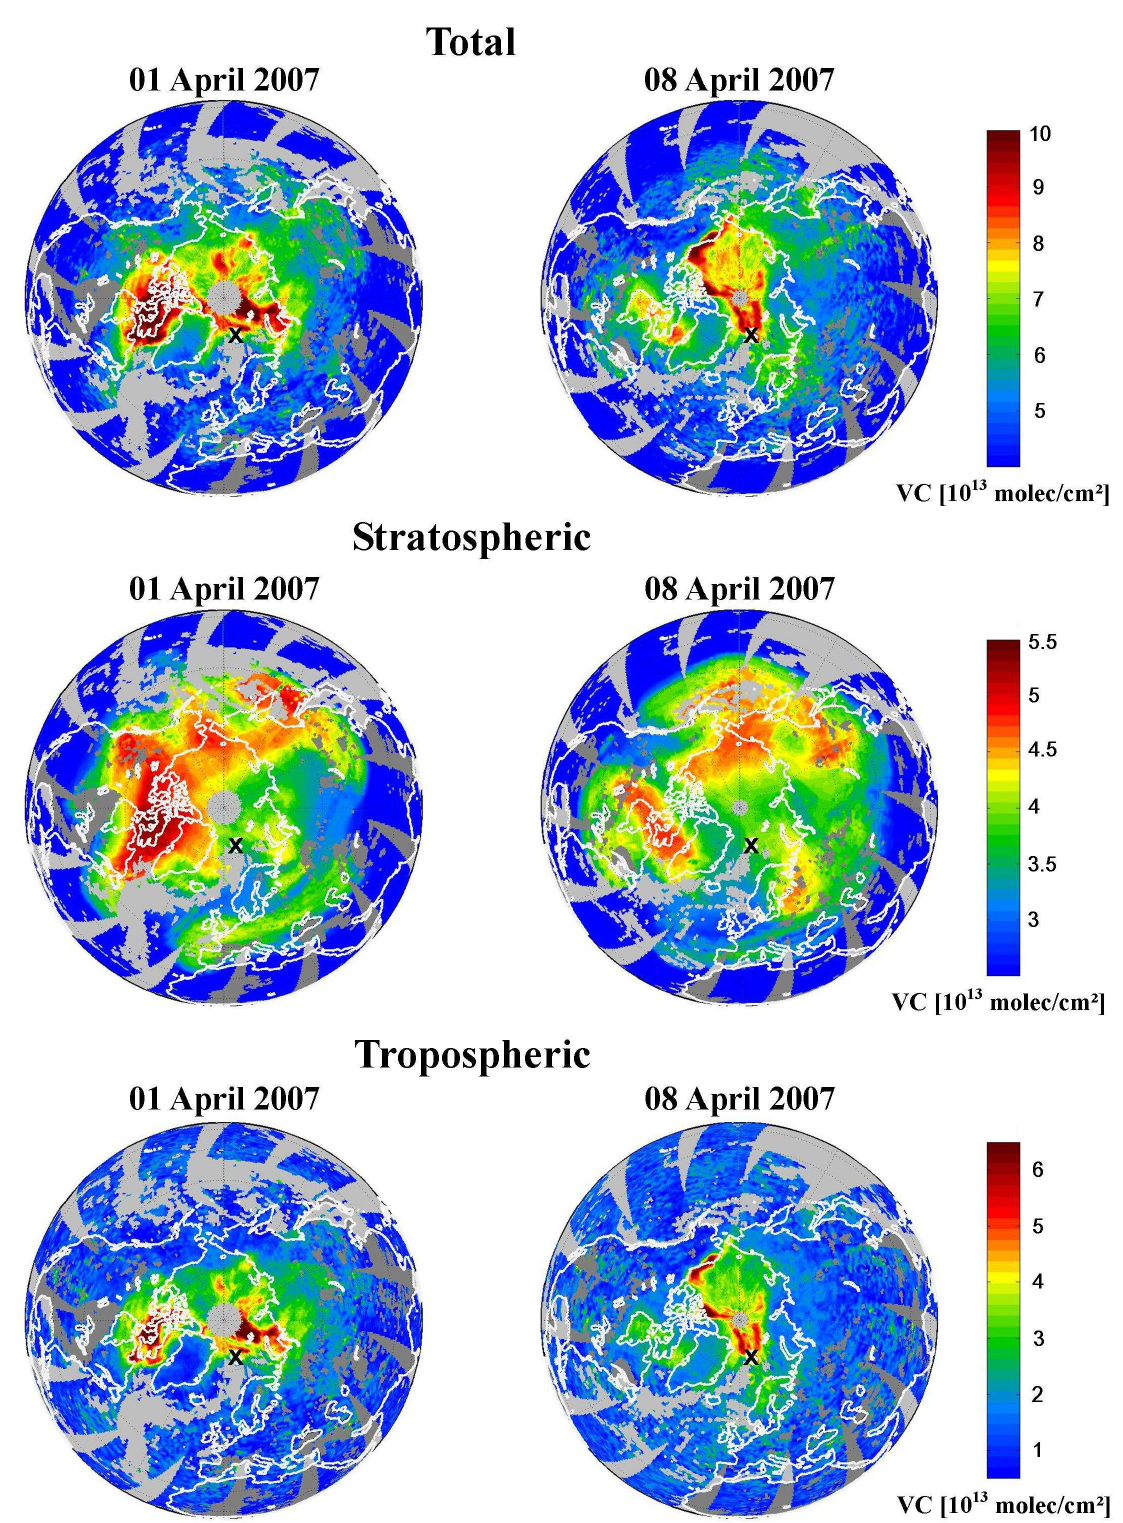
Fig. 10. GOME-2 total (upper panels), stratospheric (middle panels) and tropospheric (low panels) BrO Vertical Column Densities for the 1 and 8 April 2007 (left and right column, resp.). The island of Spitsbergen, base of the ASTAR 2007 campaign, is marked with black crosses. Details of the retrieval method are given in Theys et al. (2011).